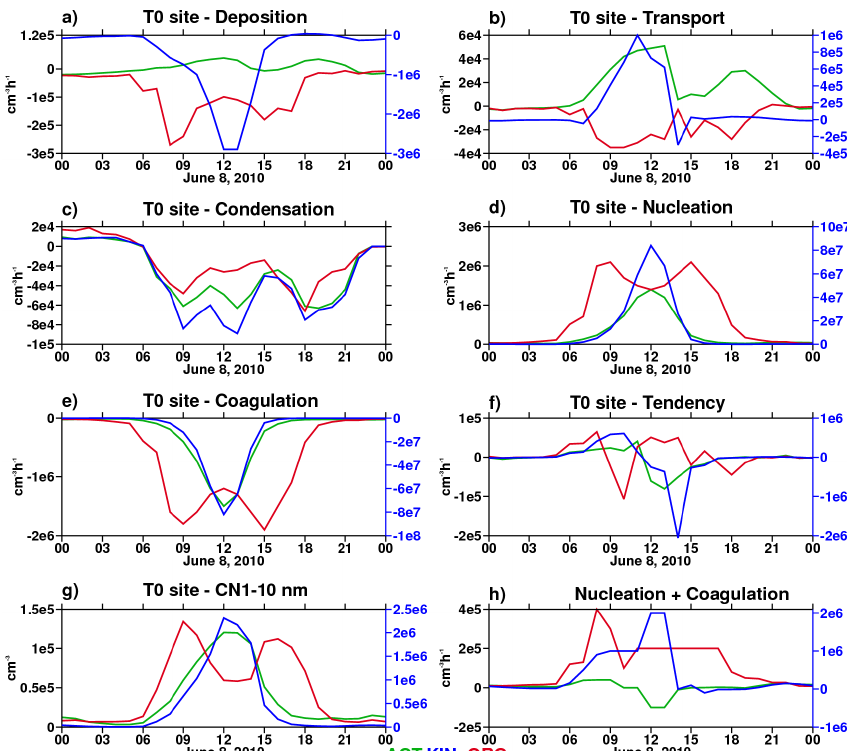
Figure 8. Budget diagnostic terms for 1–10nm particles at the T0 site on 8 June: (a) dry deposition; (b) transport; (c) condensation; (d) nu- cleation; (e) coagulation; (f) total tendency; (g) particle number concentration; and (h) tendency of particles coming from nucleation and coagulation processes. The left-hand side (black) vertical axes are for ACT and ORG. The right-hand side (blue) axes are for KIN, which gave larger budget